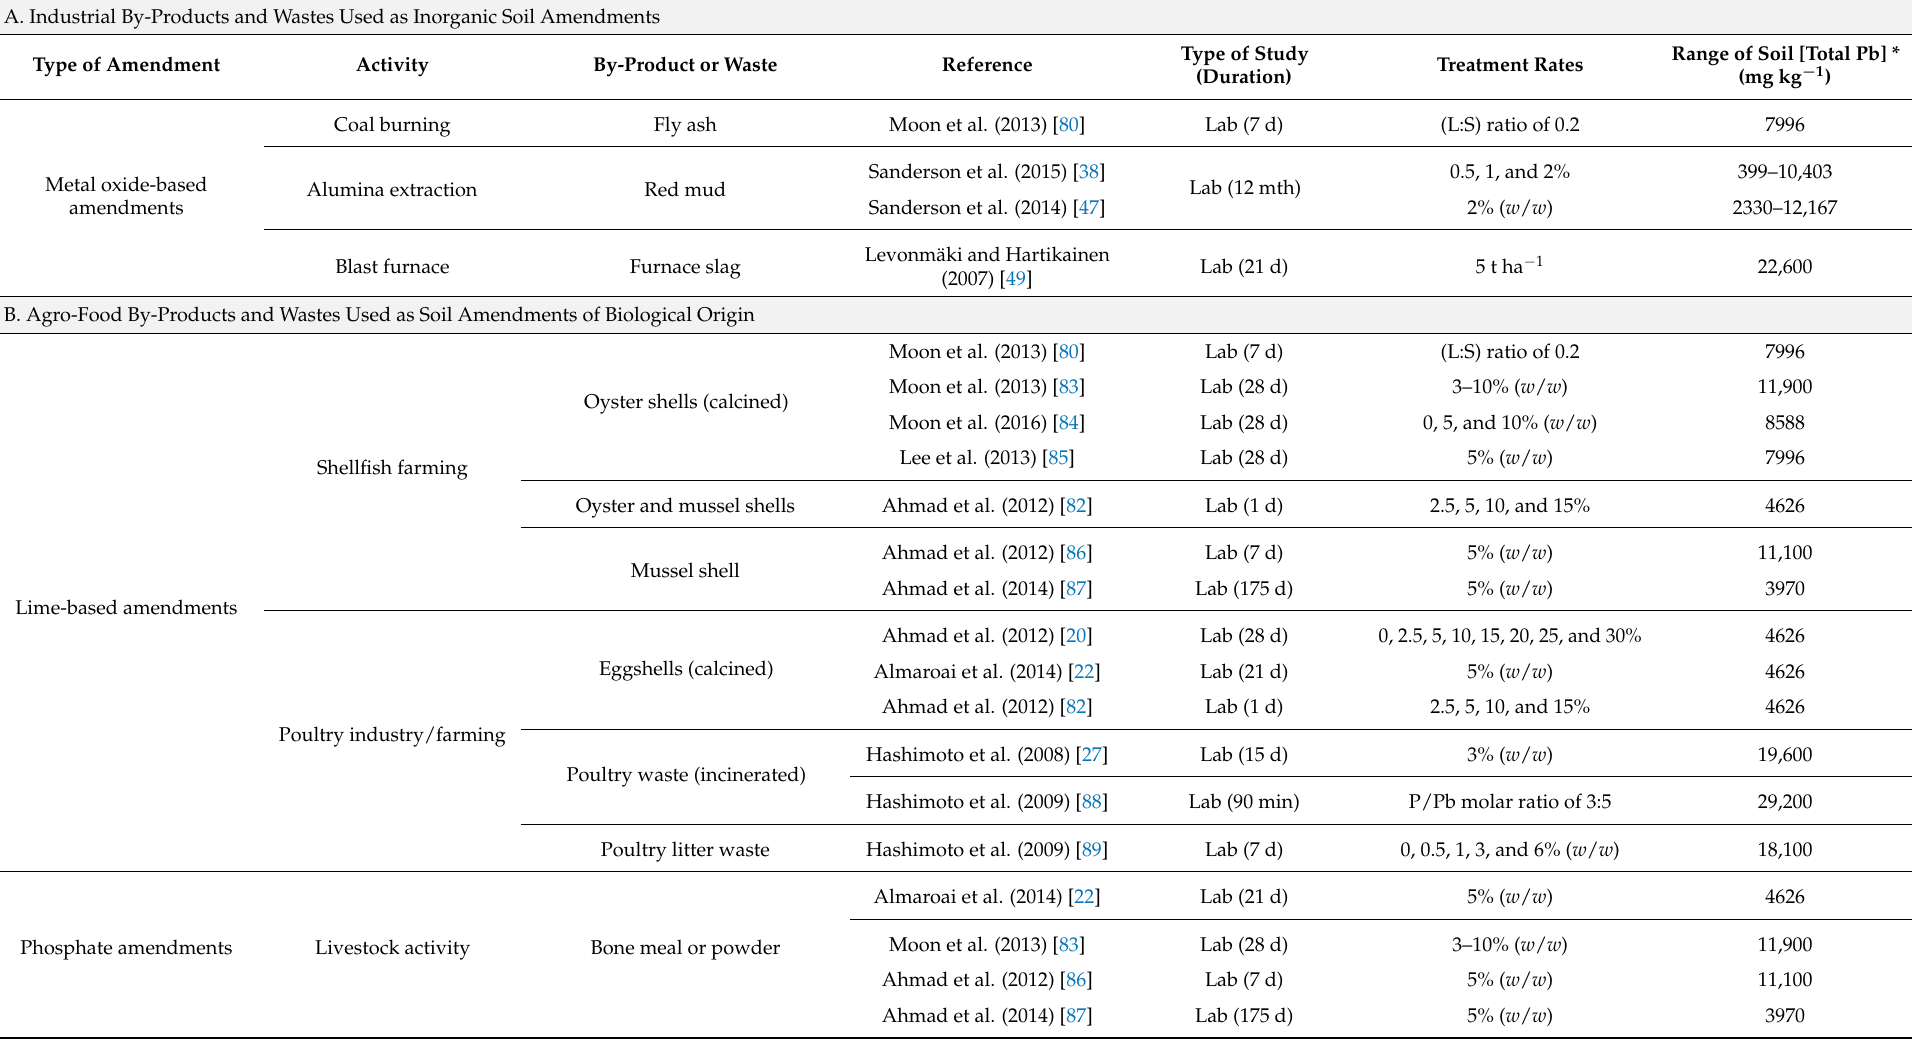
Table 3. Industrial ( A ) and agro-food ( B ) by-products and wastes used as amendments for Pb immobilization in shooting range